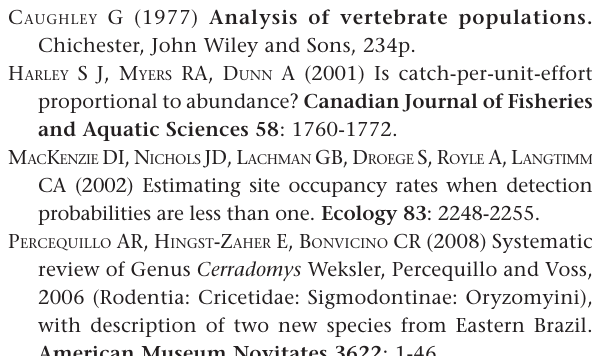
Table 1. Correlation between the monthly frequencies of captures ) and the monthly frequency of trapped animals (FTA (FC i